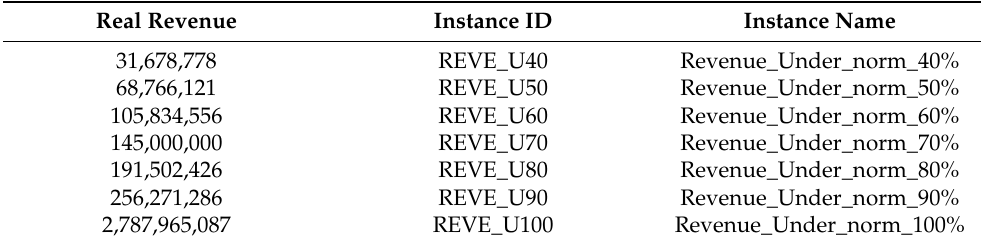
Table A4. Categorization criteria of “Revenue” class in the experiment.